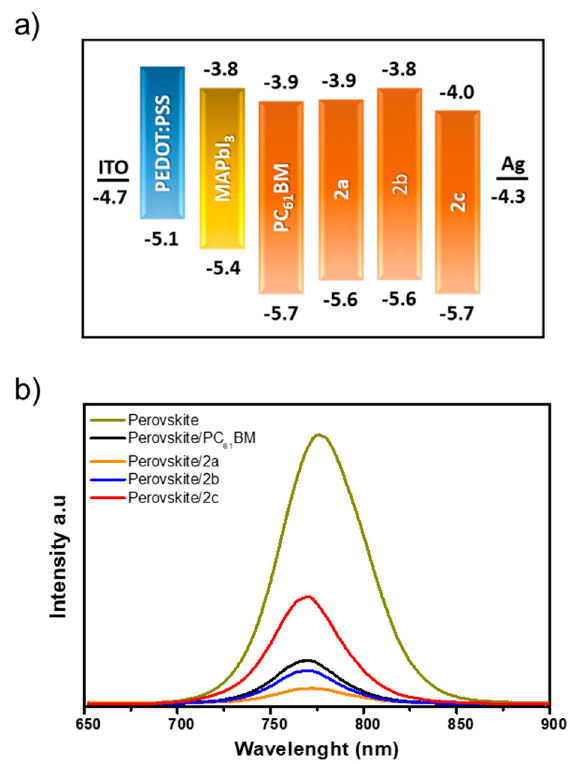
Figure 2. ( a ) Schematic illustration of the estimated HOMO and LUMO energy levels, estimated from cyclic voltammetry (CV) and UV-vis. ( b ) Steady-state photoluminescence (PL) spectra of the perovskite and perovskite/ETM films.